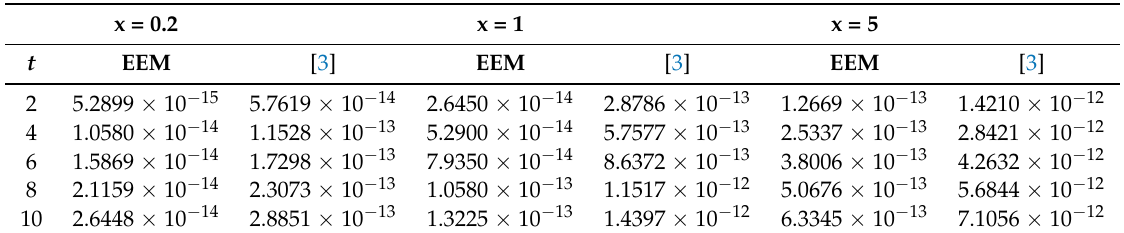
Table 1. Comparisons between the results obtained by the LMM with those adapted from [3] for Test Problem 1.